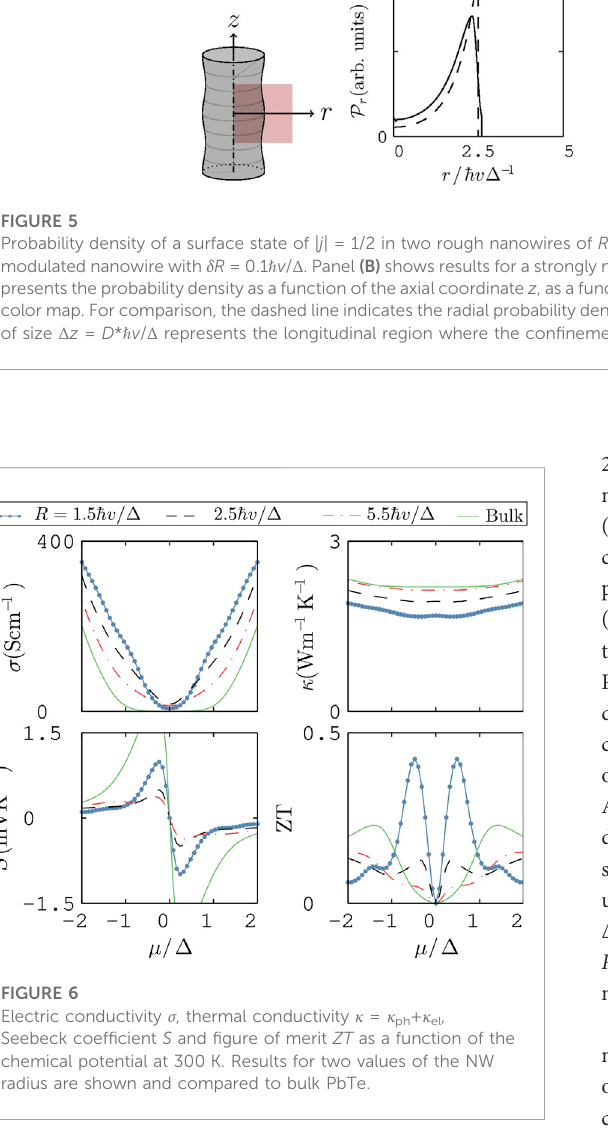
Figure 6 collects the results for a uniform PbTe NW at T = 300K. The thermoelectric response of SnTe NWs is similar and it will not be reported here. Three different radii ( R = 1.5 Z v / Δ , R =